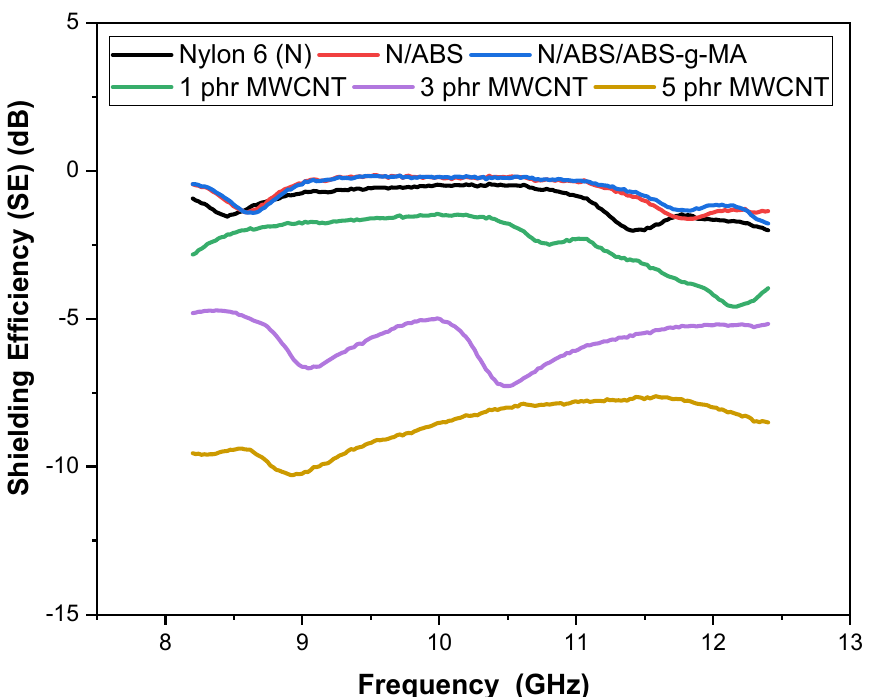
Figure 4. Shielding efficiency as a function of frequency for Nylon 6, blends, and nanocomposites. N = Nylon 6.